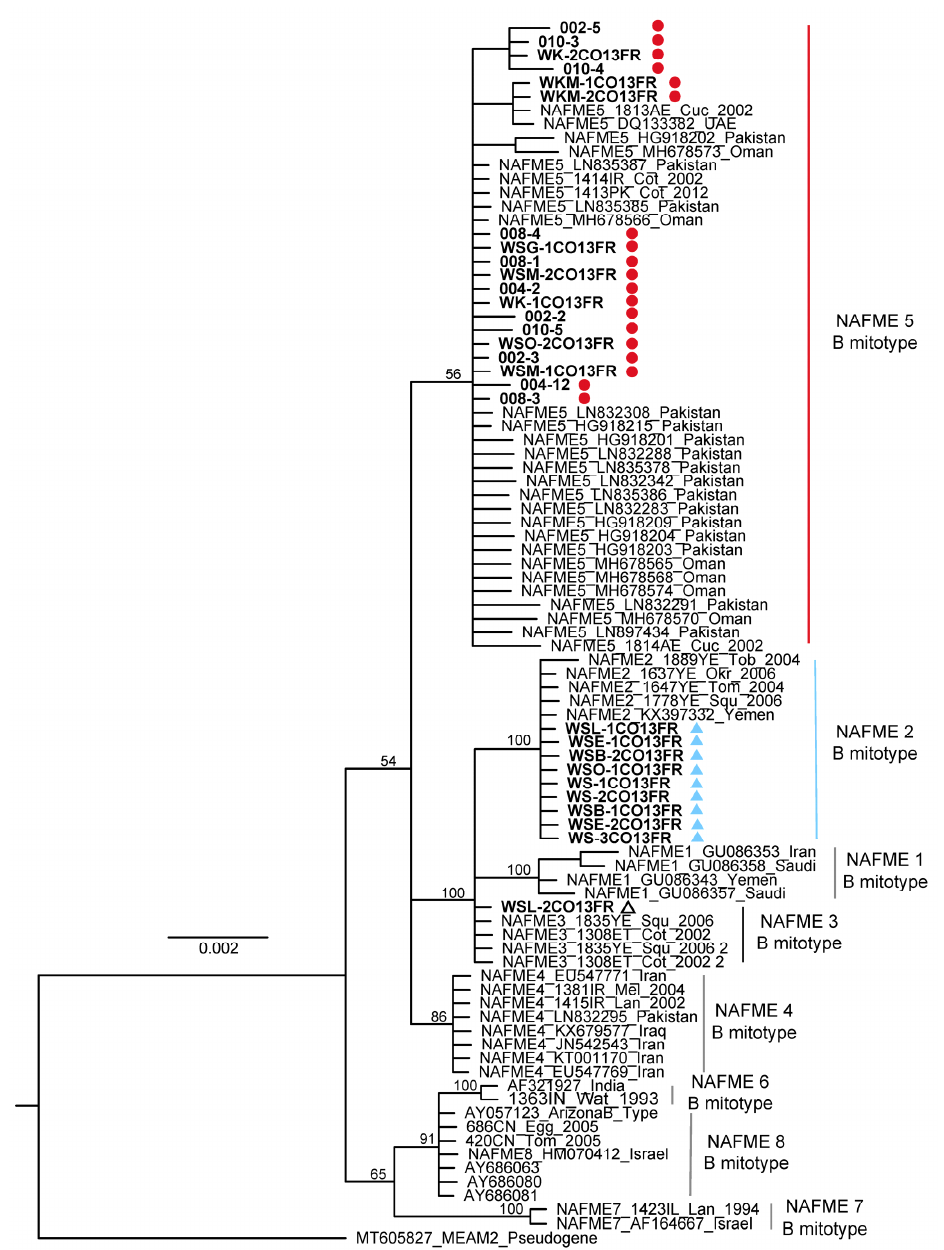
Figure 1. Maximum likelihood tree for mitochondrial cytochrome oxidase I gene sequences of the NAFME haplotype groups, reconstructed using RaxML. Whitefly haplotypes NAFME 2, 3, and 5 grouped most closely with reference sequences belonging to the North Africa–Middle East (NAFME) clade. One thousand bootstrap iterations were carried out, and statistical support values (>60%) were placed at the major